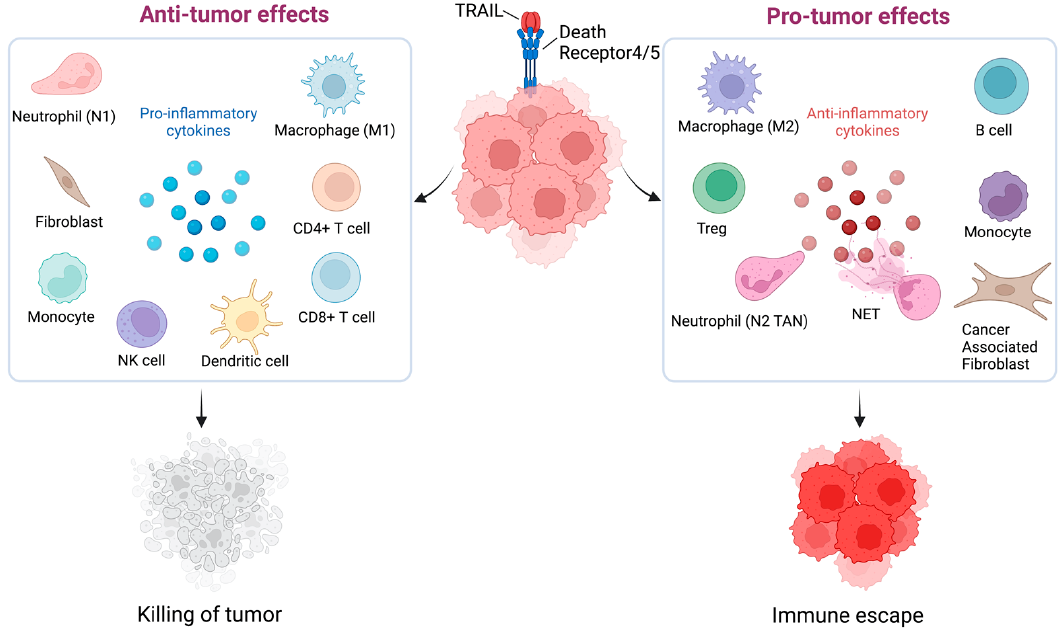
Figure 2. Immunomodulatory effects of TRAIL DR pathways. The TRAIL/TRAIL-R pathway can impart both pro- and anti- tumorigenic effect on the tumor microenvironment. Endogenous TRAIL expressed by the immune cells of the tumor microenvironment (left panel), or exogenous TRAIL contribute to the anti-tumorigenic defense mechanism of TRAIL, thus killing the tumor cells (shown on the left). On the other hand, exogenous TRAIL either directly or via immune cells may activate the secretion of inflammatory cytokines promoting infiltration of immune suppressor cells (M2 macrophages, Tregs, Tumor Associated Neutrophils [TAN]/N2 TAN, pro-tumoral monocytes and B cells), resulting in immune escape contributing to pro-tumorigenic effect of TRAIL (shown on the right). Figure was created with BioRender.com (accessed on 8 November 2022).